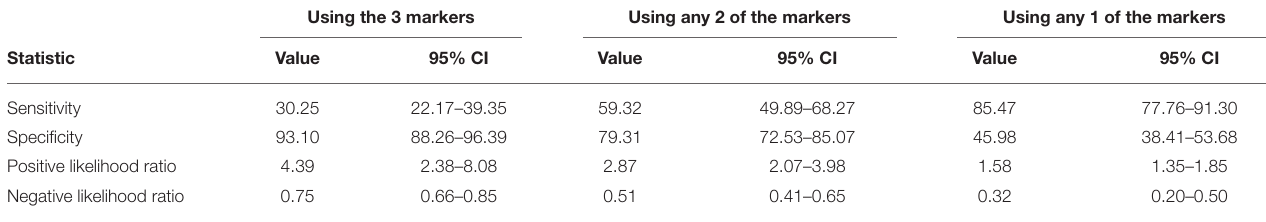
TABLE 8 | Validation of the three predictors on a larger cohort ( n = 289) of COVID-19 patients suing to show different Sensitivity, Specificity, Positive Likelihood Ratio, and Negative Likelihood Ratio. Using the 3 markers Using any 2 of the markers Using any 1 of the